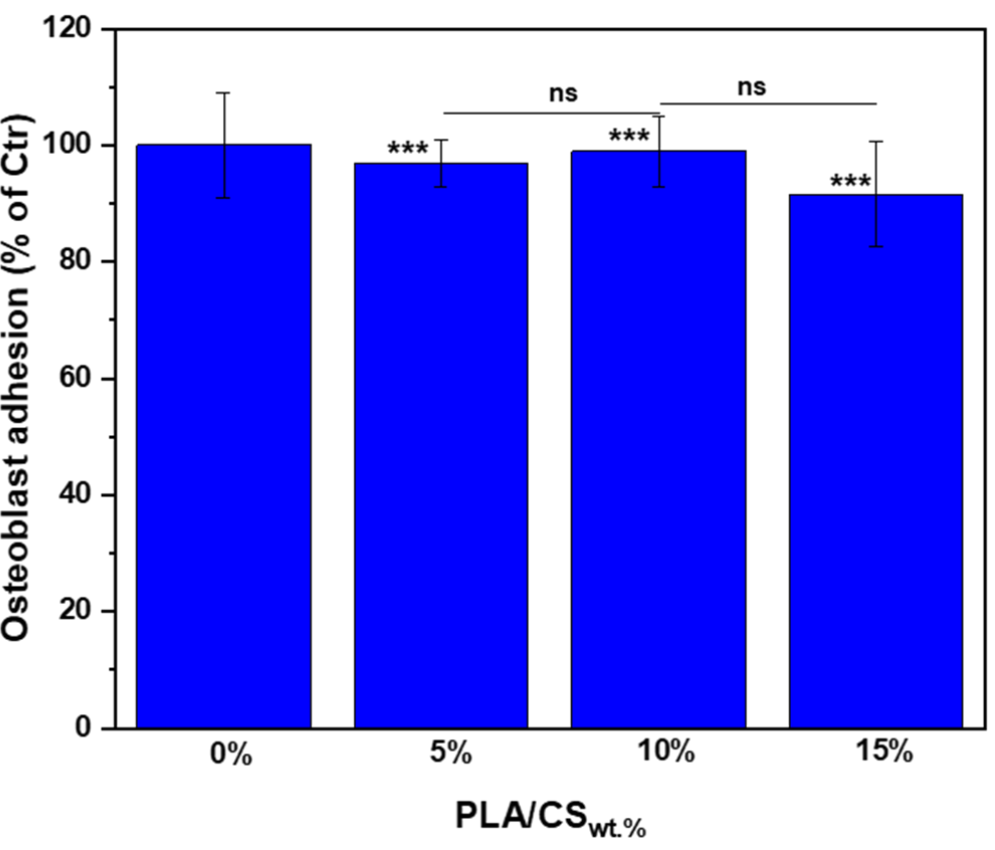
Figure 8. Osteoblast cells adhesion into pure PLA (Control, Ctr) and PLA/CS porous compos- ite scaffolds: ( a ) Hoechst staining (qualitative); ( b ) MTS assays (quantitative). (Scale bar on the pictures = 50 µ m), (*** p < 0.001; ns = not